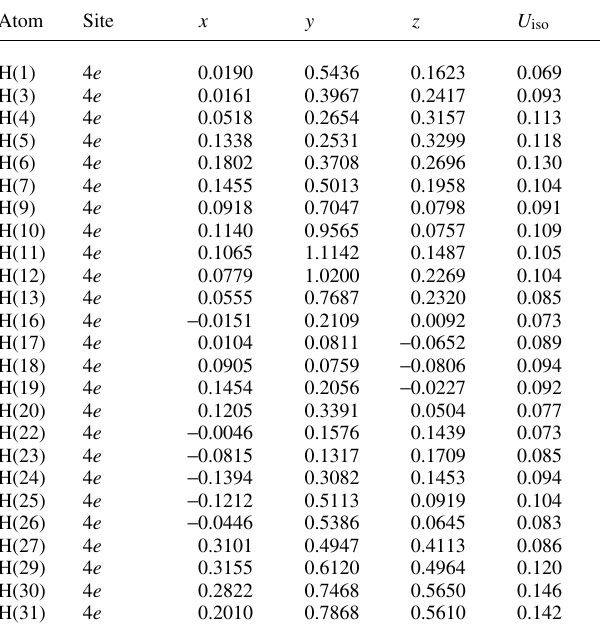
Table 2. Atomic coordinates and displacement parameters (in Å 2 )